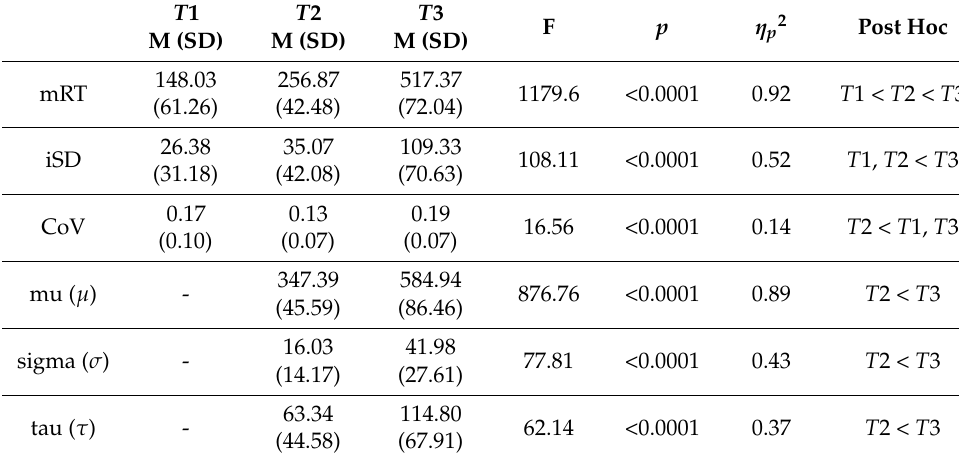
Table 2. Results of speed and variability indicators in three main tasks with repeated-measures ANOVA outcomes. Parametric indices (mRT, iSD, CoV) were corrected for the manual speed and variability assessed by the FT test. The ex-Gaussian ( µ , σ , τ ) indexes were calculated on non-normalized RTs without FT-correction, however after initial data treatment, as presented in Section 2.3.